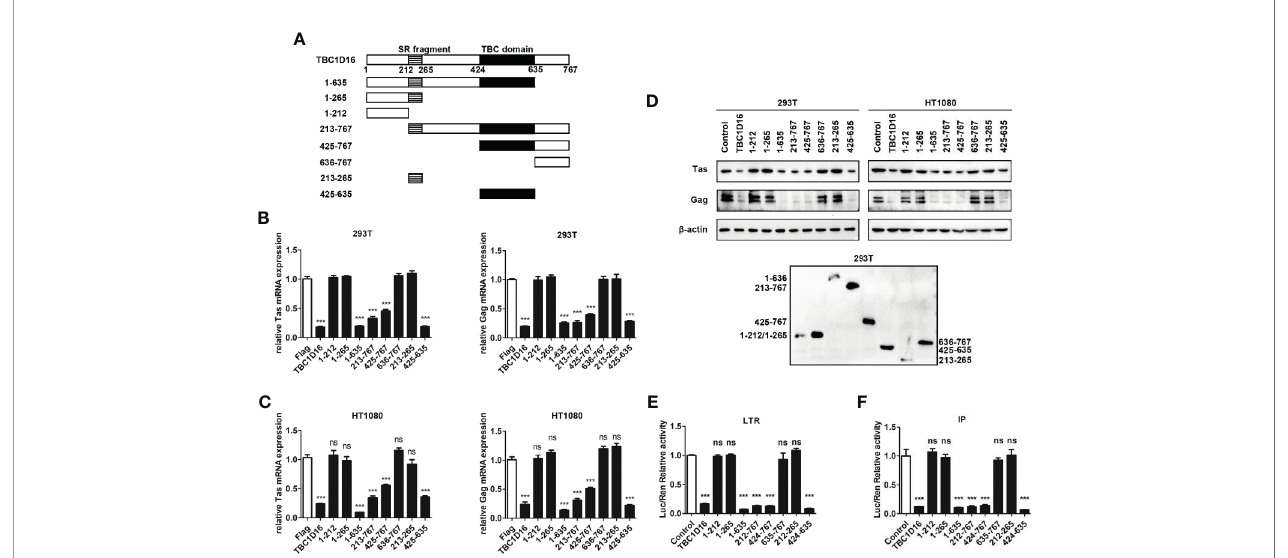
FIGURE 4 | The TBC domain of TBC1D16 is important for TBC1D16 to inhibit PFV transcription and replication. (A) Schematic diagram of full-length TBC1D16, indicating the C-terminal TBC domain and Ser rich (SR) domain,and truncation mutants used in subsequent analyses. (B, C) pCMV-Flag-TBC1D16 truncated plasmids (pCMV-Flag as an empty control) were transfected into HEK293T (B) and HT1080 (C) cells for 24 h. After transfection, cells were infected with PFV (MOI = 0.5) for 48 h. The mRNA expression of PFV Tas and Gag was detected by qPCR (*** p < 0.001 and ns , no signi fi cance). (D) pCMV-Flag-TBC1D16 truncated plasmids (pCMV-Flag as an empty control) were transfected into HEK293T and HT1080 cells for 24 h. After transfection, cells were infected with PFV (MOI = 0.5) for 48 h. The protein expression of PFV Tas and Gag was detected by western blotting. The expression of TBC1D16 truncated plasmids were detected by anti-Flag antibody in HEK293T cells. (E) pCMV-Flag-TBC1D16 truncated plasmids (400 ng and pCMV-Flag as an empty control), pRL-TK (3 ng), pTK-Tas (30 ng) and pGL3- PFV-LTR-luc (30 ng) fi re fl y luciferase reporter plasmid were cotransfected into HEK293T cells for 48 h. Luciferase reporter assay was used to detect LTR promoter activity (Renilla luciferase was used as an internal control) (*** p < 0.001 and ns , no signi fi cance). (F) pCMV-Flag-TBC1D16 truncated plasmids (400 ng and pCMV- Flag as an empty control), pRL-TK (3 ng), pTK-Tas (20 ng) and pGL3-PFV-IP-luc (20 ng) fi re fl y luciferase reporter plasmid were cotransfected into HEK293T cells for 48 h. Luciferase reporter assay was used to detect IP promoter activity (Renilla luciferase as an internal control) (*** p < 0.001 and ns , no signi fi